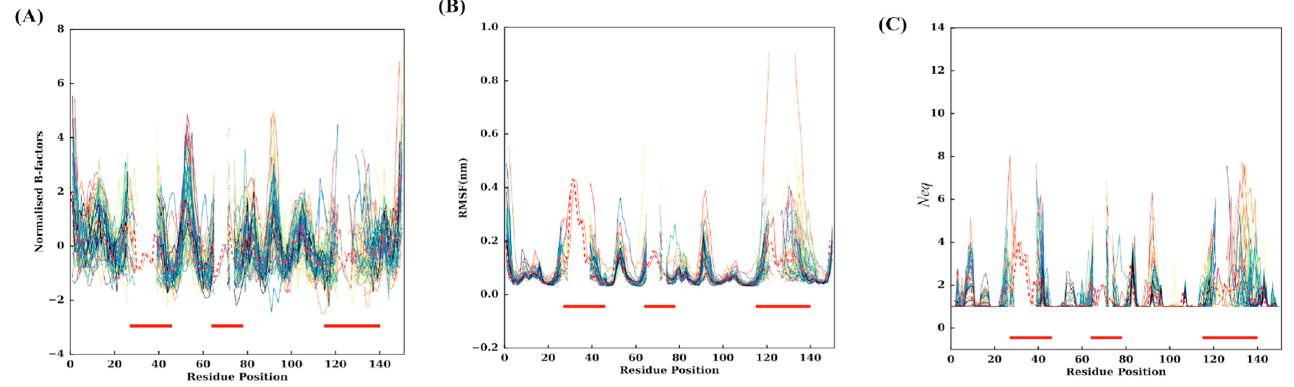
Figure 2. Flexibility metrics at each residue position. ( A ) Representation of normalised C α B-factors; the x -axis is the residue position in the MSA and the y -axis the normalised C α B-factor values. ( B ) Representation of C α RMSF values. ( C ) Representation of N eq values. The three CDR regions are highlighted using three red-coloured regions at the bottom of the plots. The average values of each metric are shown in dotted red lines.